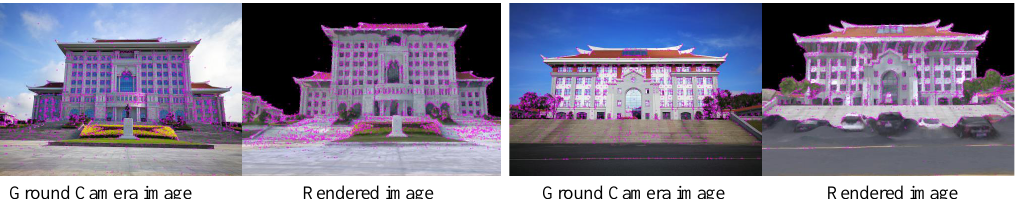
Figure 2. Detailed enlargements of a ground camera image and the corresponding rendered image from a 3D image-based point cloud. Top: Detailed enlargements of a ground camera image; Bottom: Detailed enlargements of a corresponding rendered image. Within the same colored bounding box are the two rows representing the corresponding paired image patches of the ground camera image and the corresponding rendered image.